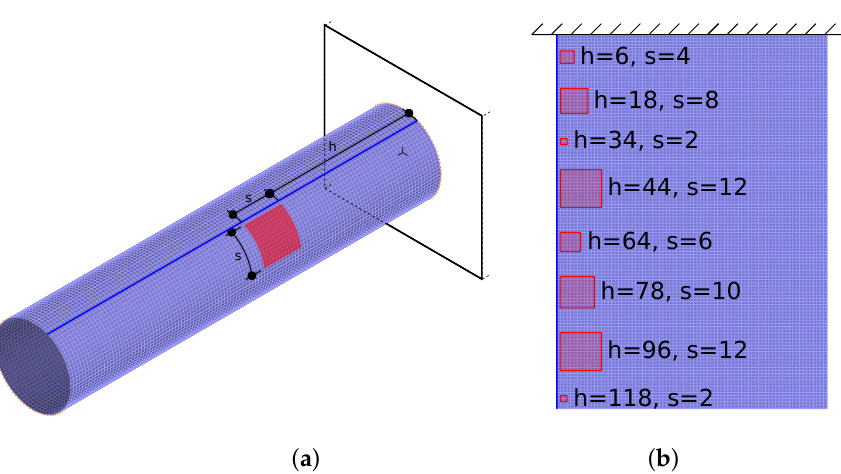
Figure 3. The cylinder ( a ) and its lateral surface unrolled ( b ), with some examples of material degradation zones and the corresponding values of parameters h (location) and s (size).